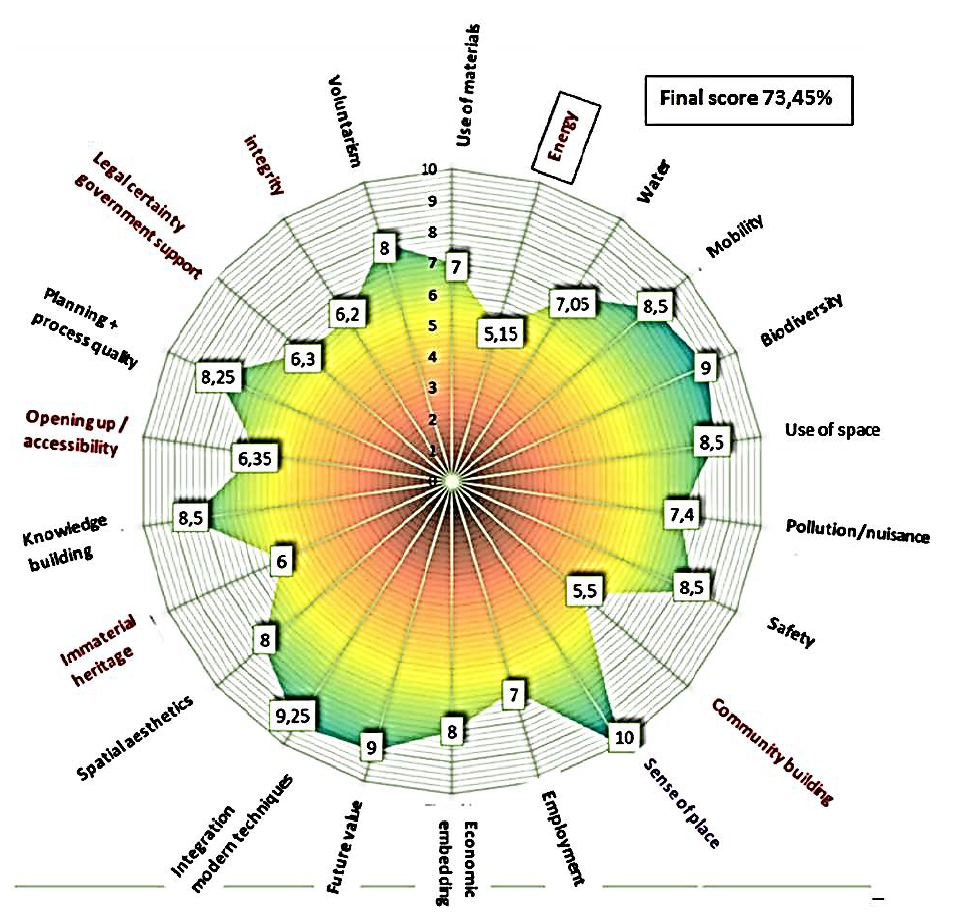
Figure 7. Chart Beguinage area—Minnewater.